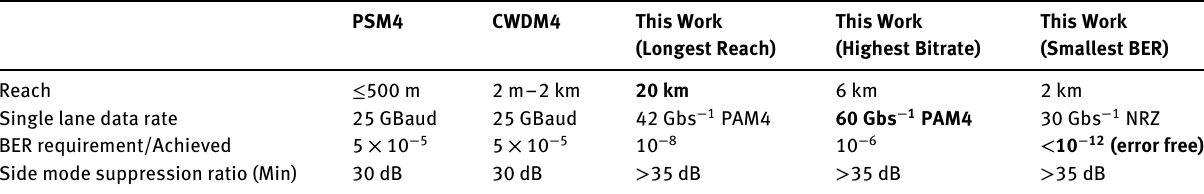
Table 1: Comparison of the frequency comb source for IMDD high-speed data, with transmitter specifications for the PSM4 and CWDM4 MSAs. The metrics achieved in our frequency comb source meet or exceed those stipulated by the MSAs.